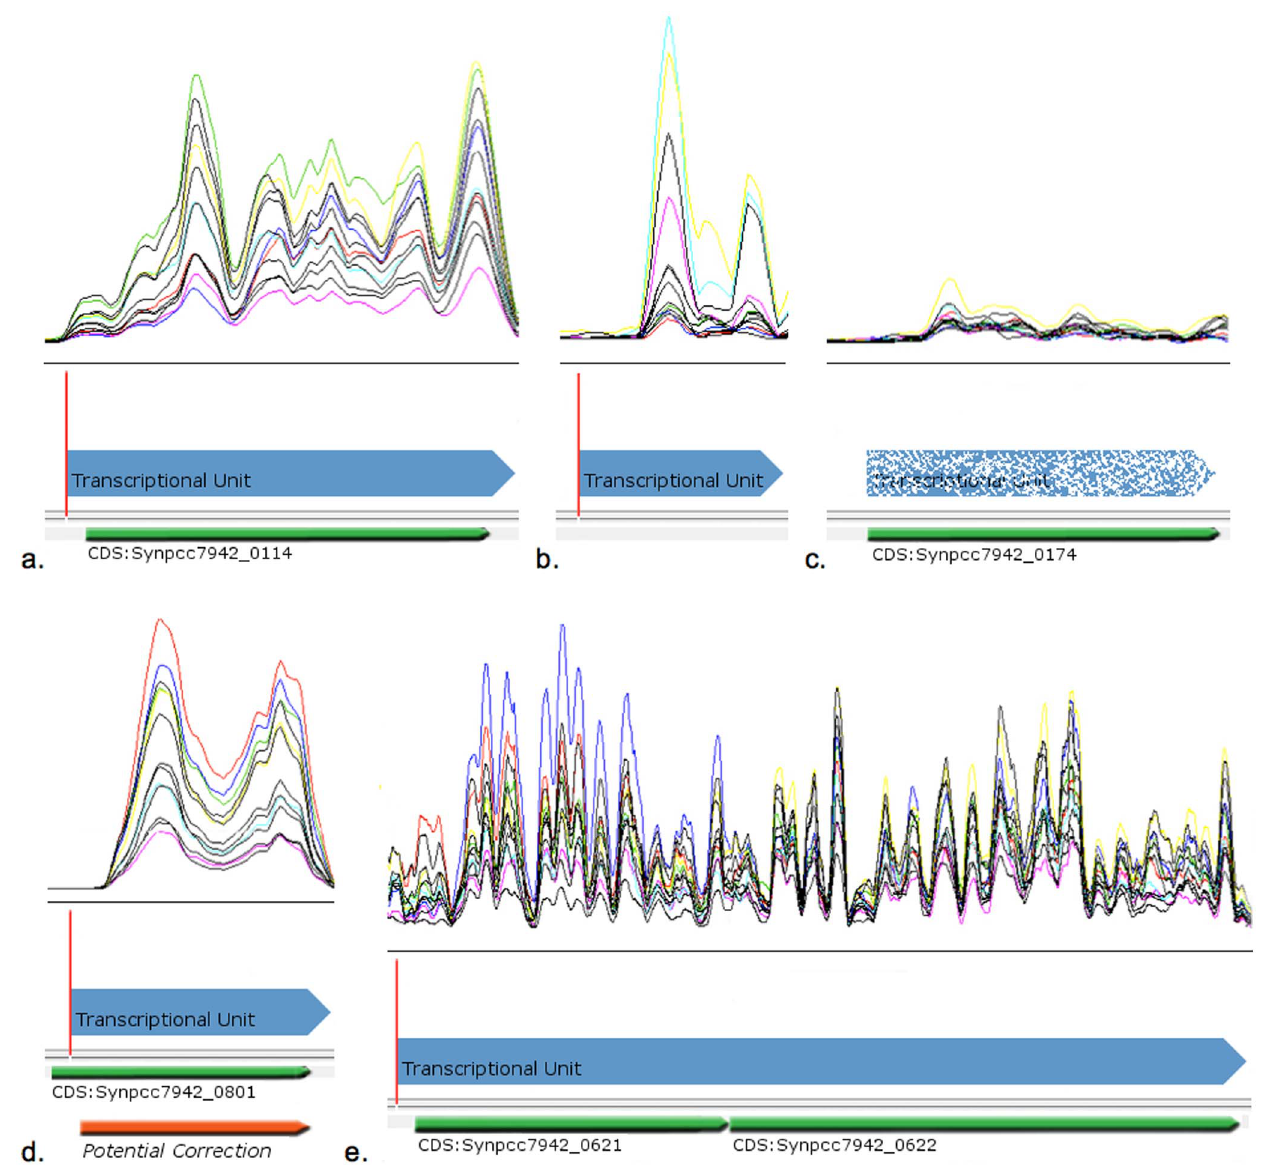
Figure 1. Regions of the genome combined with annotation, RNA-seq expression and 5 9 peaks information. The colored lines represent the expression coverage of this region in each condition. Green arrows represent the existing annotation. 5 9 peaks are indicated with a vertical red line, blue arrows that follow 5 9 peaks denote the potential Transcriptional unit and follows the expression of this region. a. Example of a CDS of Synechococcus (Synpcc7942_0114) with one clear 5 9 enriched indication, RNA-seq coverage and proper annotation. b. Example of a TU inside non-coding region with one clear 5 9 peak. c. Example of an annotated CDS (Synpcc7942_0174) without 5 9 peak and ambiguous RNA-seq coverage. d. Example of a CDS (Synpcc7942_0801) with evidence of structural misannotation since the 5 9 peak is located 60 bps after the annotated start site. e. Two annotated genes with contiguous expression and a peak at the 5 9 of the first gene suggesting that both CDSs are expressed together as one transcript forming an